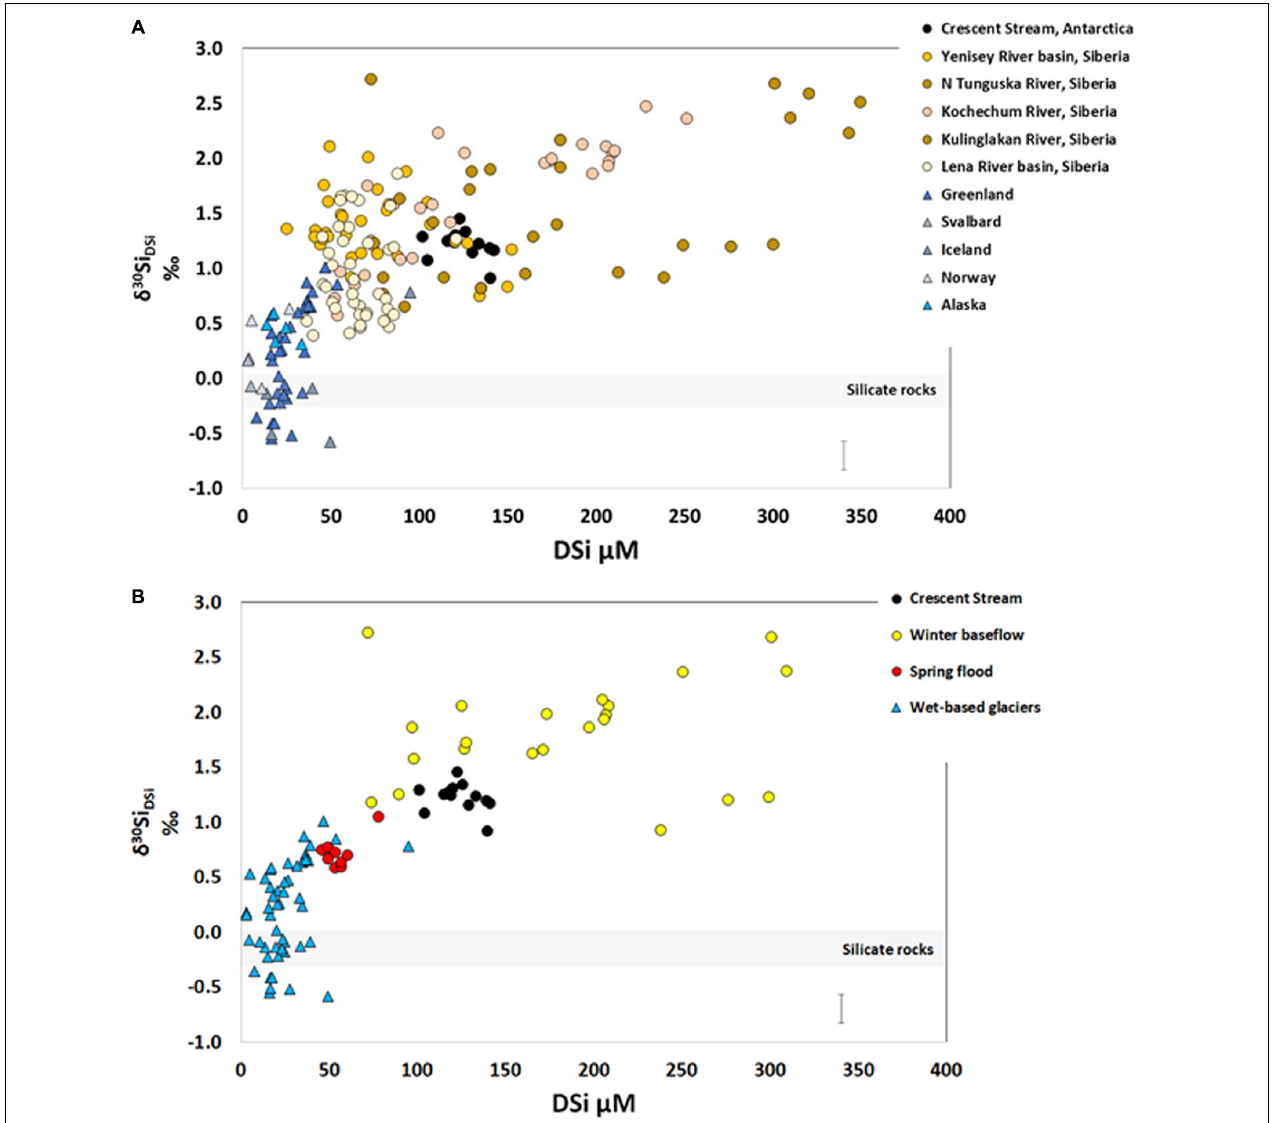
FIGURE 8 | (A) Synthesis of dissolved silicon isotope ( δ 30 Si DSi ) compositions in glacial rivers (different blue colors), non-glacial permafrost-dominated river basins (different brown colors), and Crescent Stream for 2014–2015, 2015–2016, 2016–2017 seasons (black). Data sources: Pokrovsky et al., 2013; Mavromatis et al., 2016; Sun et al., 2018; Hatton et al., 2019b. (B) Comparison between δ 30 Si DSi compositions in Crescent Stream, with those in (i) permafrost-dominated rivers during winter baseflow, (ii) permafrost-dominated rivers during spring flood (Pokrovsky et al., 2013; Sun et al., 2018), and (iii) wet-based glacial rivers (Hatton et al., 2019b), showing that δ 30 Si DSi compositions in Crescent Steam during the austral summer months correspond to δ 30 Si DSi compositions in Arctic rivers during winter baseflow. The gray band shows the range of δ 30 Si in silicate rocks (Georg et al., 2007b; Savage et al., 2010, 2011; Armytage et al., 2011). The error bar corresponds to the maximum standard deviation (2SD) for silicon isotope